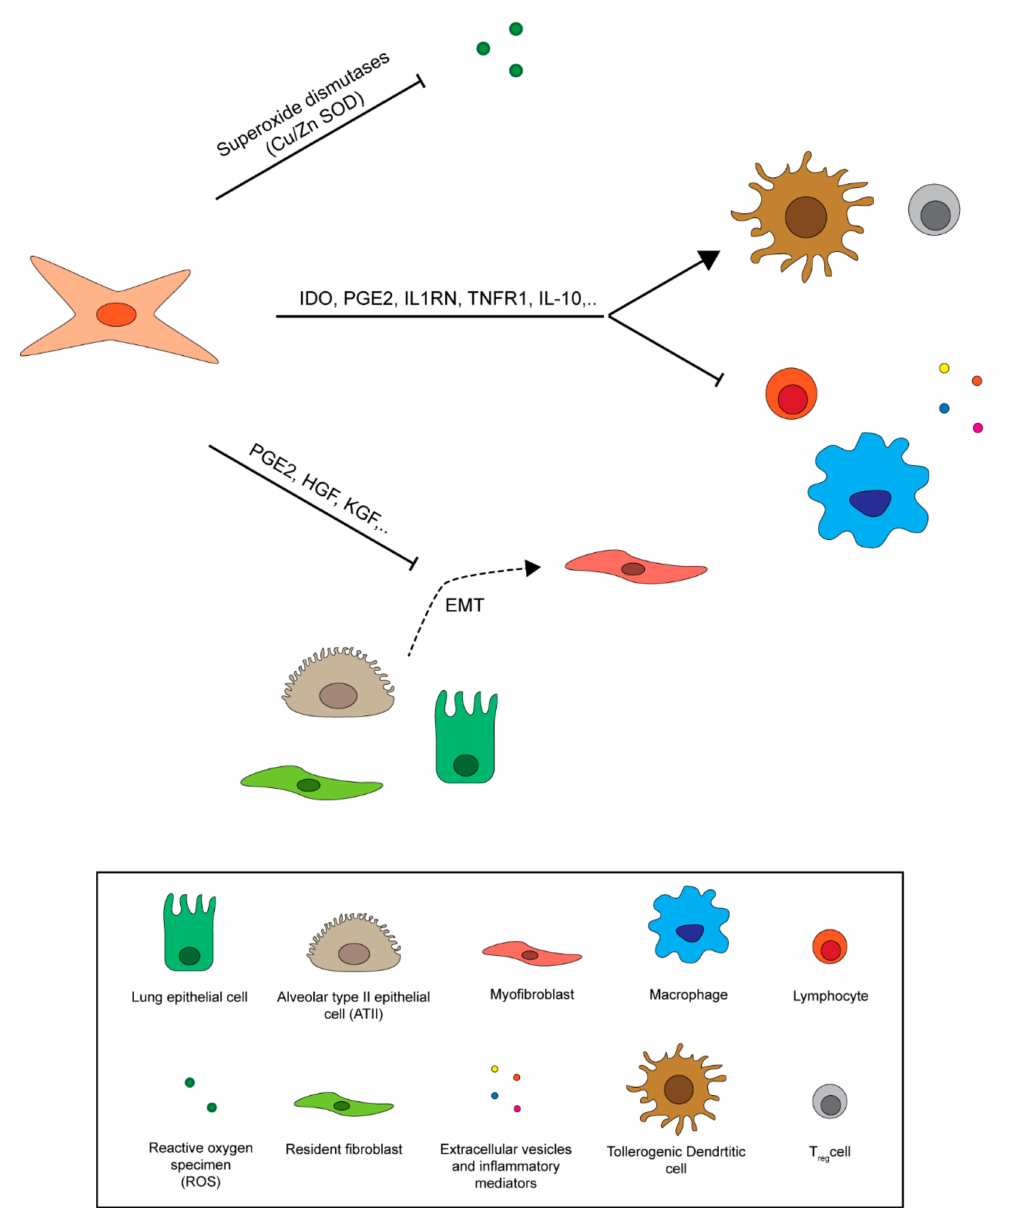
Figure 5. Mesenchymal stem cell regulation of the lung fibrotic microenvironment. MSCs protect radiation-injured lungs against ROS secreting superoxide dismutase enzymes and reduce inflammatory signaling, inhibiting immune cell activation by the release of immunosuppressive cytokines. They also limit fibrotic response by reducing myofibroblast di ff erentiation from epithelial cells and fibroblasts and ECM deposition